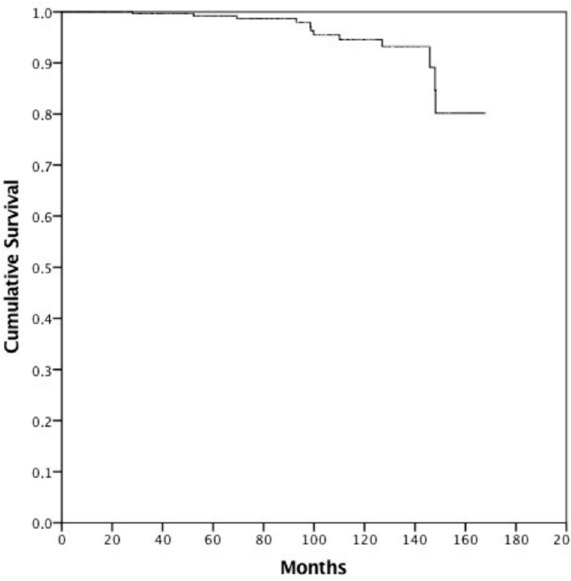
Figure 1. Cancer-specific survival.